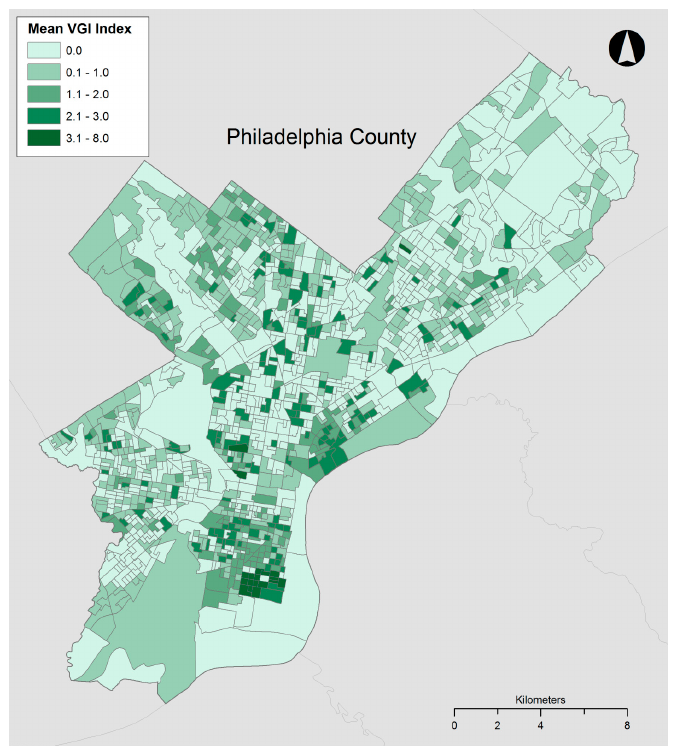
Figure 3. Philadelphia mean VGI index (the mean number of attributes per VGI tree in each block group).